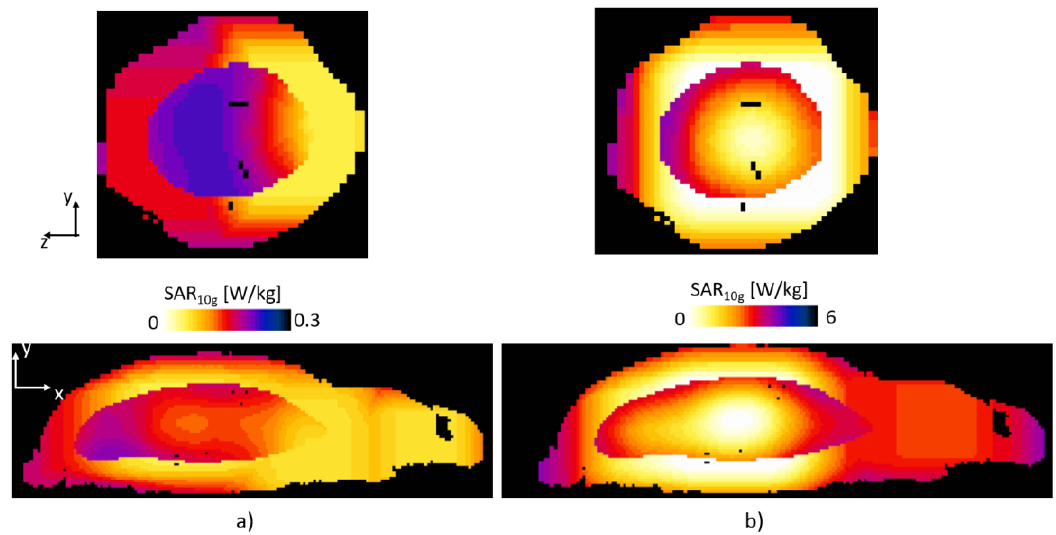
Figure 9. The SAR average 10 g acquired at ( a ) 300 MHz and ( b ) 1.06 GHz, for the z-y plane ( top ) and x-y ( bottom ). Figure 10 compares the evolution of temperature in time for a point in a nearby healthy large intestine tissue (R2) and a point at the cancer tissue (R1), at the regions marked by a circle in the top of Figure 8c. In addition, we included the volume histogram to show the evolution of the temperature in the cancer tissue Figure 10b and also on the healthy tissue Figure 10c. The histogram shows the normalized volume at different temperature